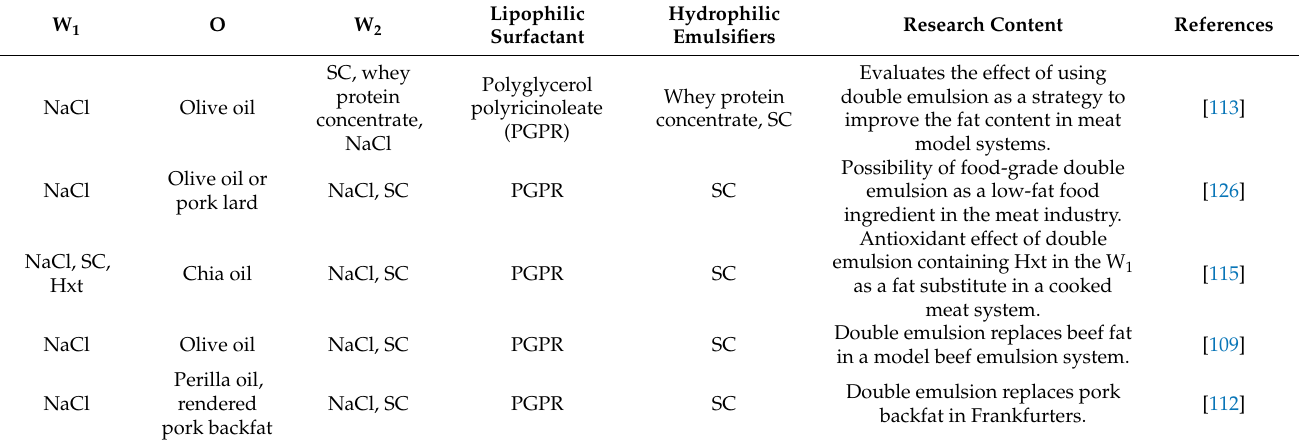
Table 2. The application of double emulsions and gelled double emulsions as fat replacers in meat products.